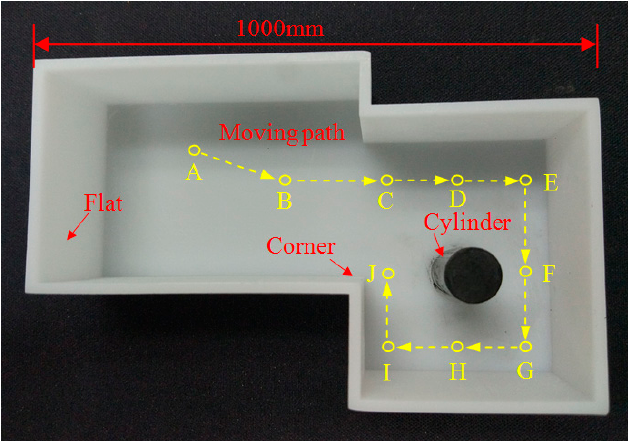
Figure 8. Environment for feature classification and mapping.